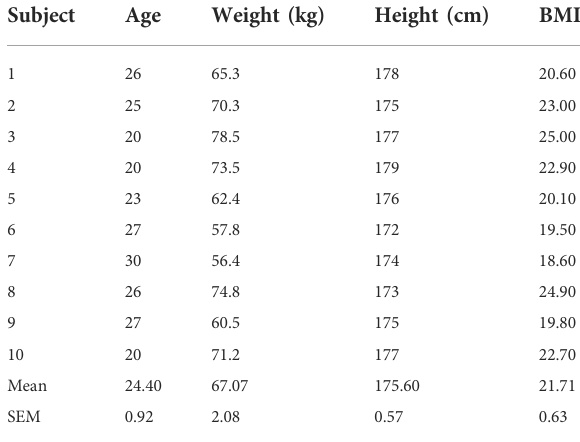
TABLE 1 Subjects ’ body composition